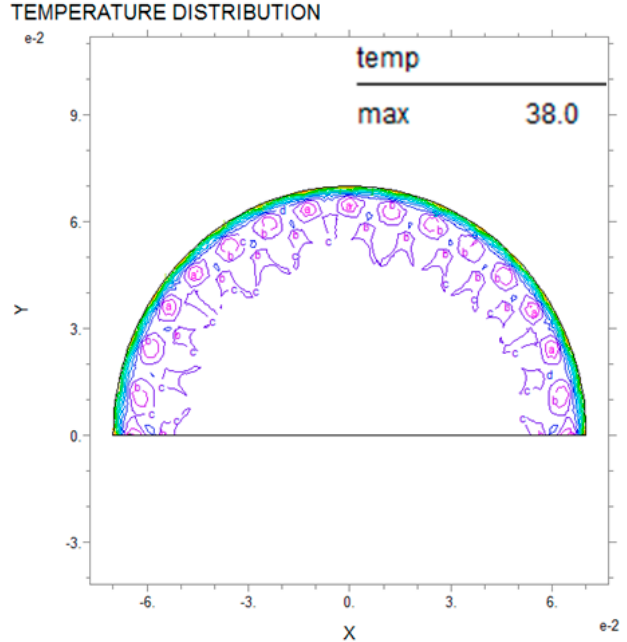
Figure 7. PDE thermal analysis at R1 = 70 mm, R2 = 3 mm.